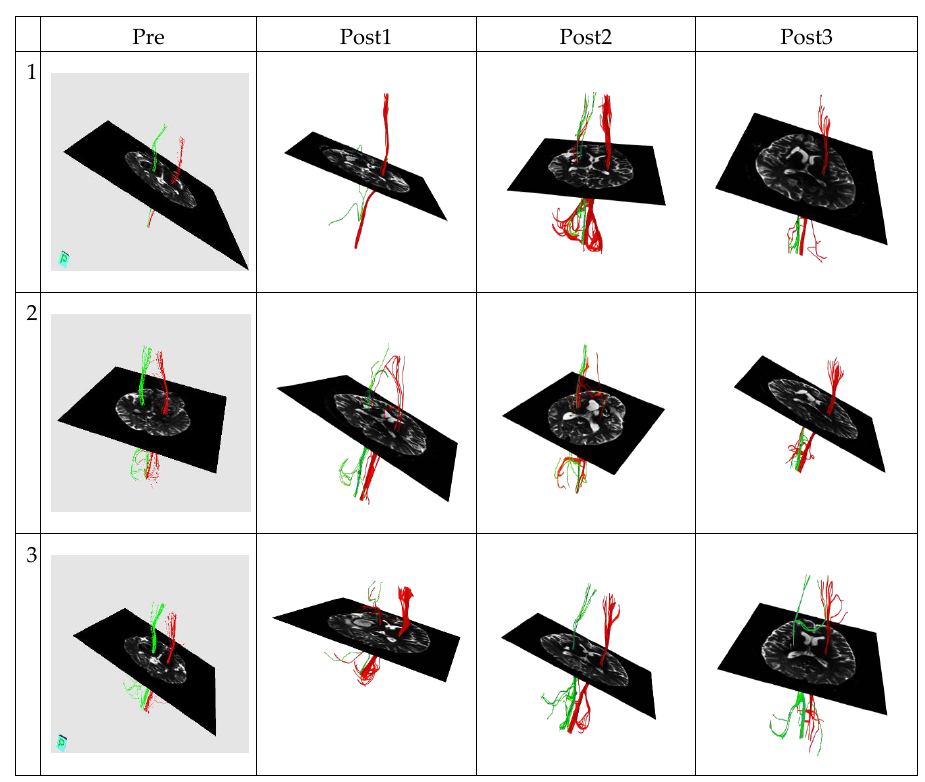
Figure 1. The corticospinal tract diffusion tensor tractography data in the good outcome group of three patients. Green represents the corticospinal tract (CST) on the left hemisphere. Conversely, red represents the corticospinal tract (CST) on the right hemisphere.